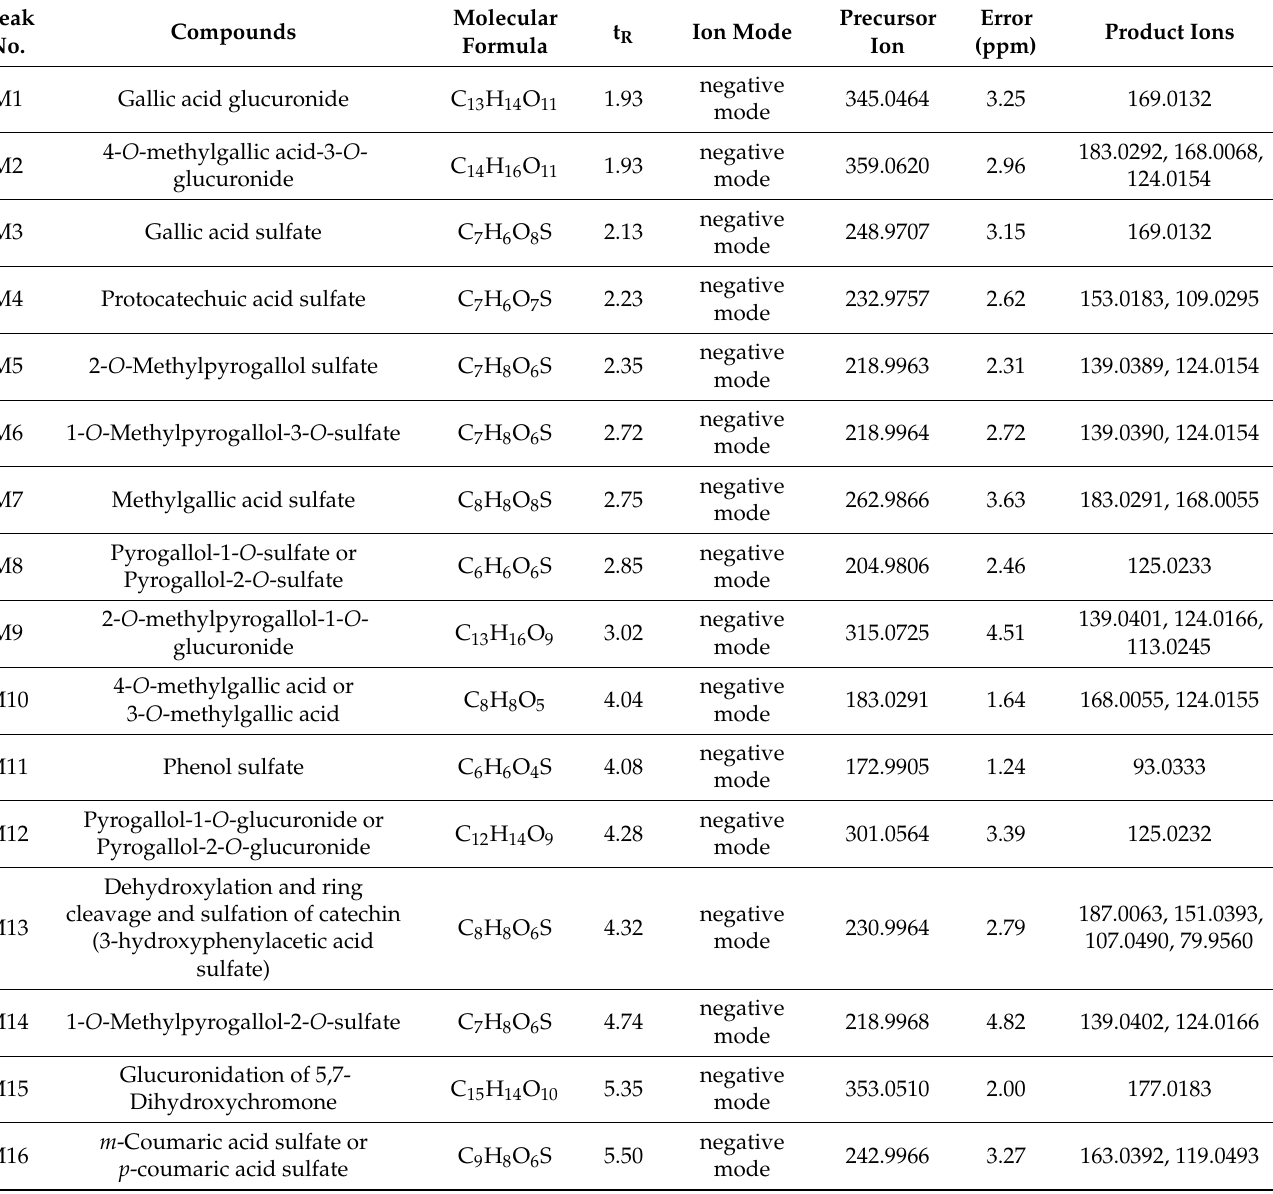
Table 1. The metabolites of P. capitatum in hyperuricemia rat